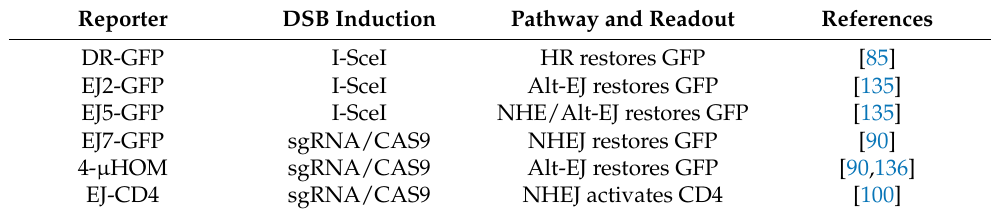
Table 1. Reporters to measure specific DSB repair pathways. Reporter column lists common names for different DSB repair reporters. DSB induction column lists enzymes used to induce DSBs for each reporter. Pathway and Readout column lists the DSB repair pathway(s) measured by each reporter and the signal activated the pathway(s). Reference column lists the original publications where the reporters are